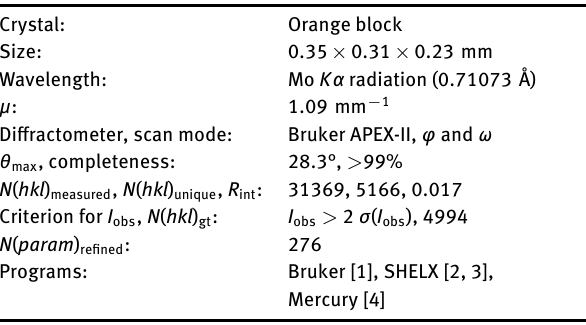
Table 1: Data collection and handling.